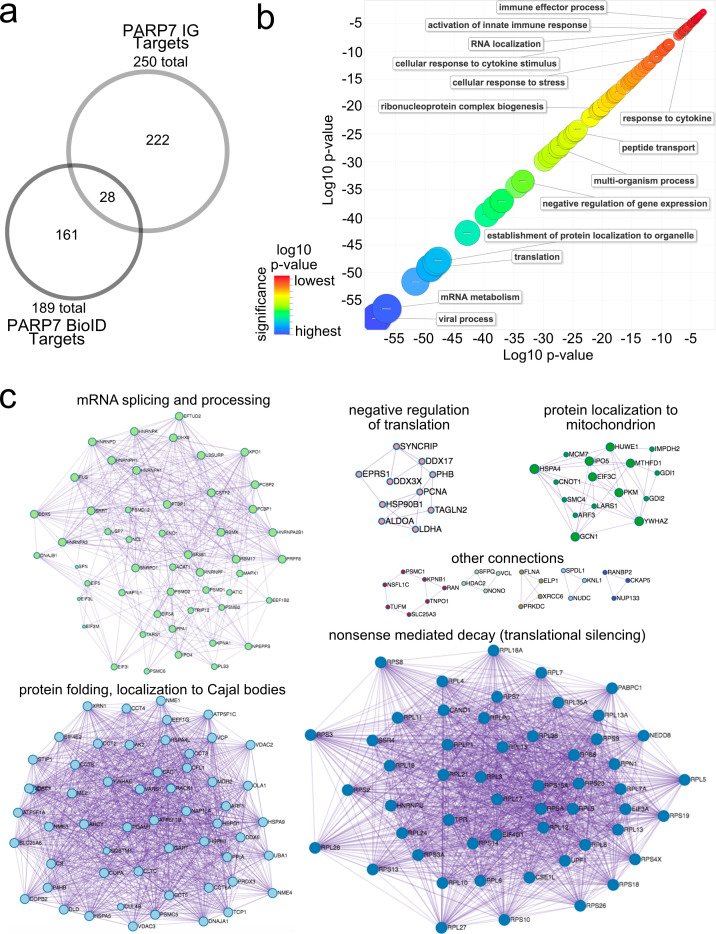
Gene ontology analysis of PARP-7 MARylation targets and interactors reveals roles in innate immune signaling and RNA regulation.(a) Venn diagram comparing the 250 total PARP-7 targets identified by LC-MS/MS runs in comparison to the 189 PARP-7 interacting proteins identified using Myc-BirA–PARP-7. Data shown are the additive combined targets of two biological replicates for each type of strategy. (b) Scatterplot depicting enriched gene ontology (GO) terms attached to the 439 total PARP-7 MARylation targets (chemical genetics) and PARP-7 interactors (BioID proximity labeling). GO term enrichment was performed using the PANTHER toolkit. Significantly enriched GO terms (p<0.05) were condensed using ReviGO and similar terms were nested based on similarity. Terms are organized by −log10(p-value). Significance ranges from −58.2 (most significant) to −2.8 (least significant). Selected terms are indicated. (c) ‘Protein-protein Interaction Enrichment Analysis’ of the 439 total PARP-7 MARylation targets and PARP-7 interactors. Images were created using Metascape.org. The Molecular Complex Detection (MCODE) algorithm has been applied to identify densely connected network components. The MCODE networks identified for individual gene lists have been gathered and are shown here.